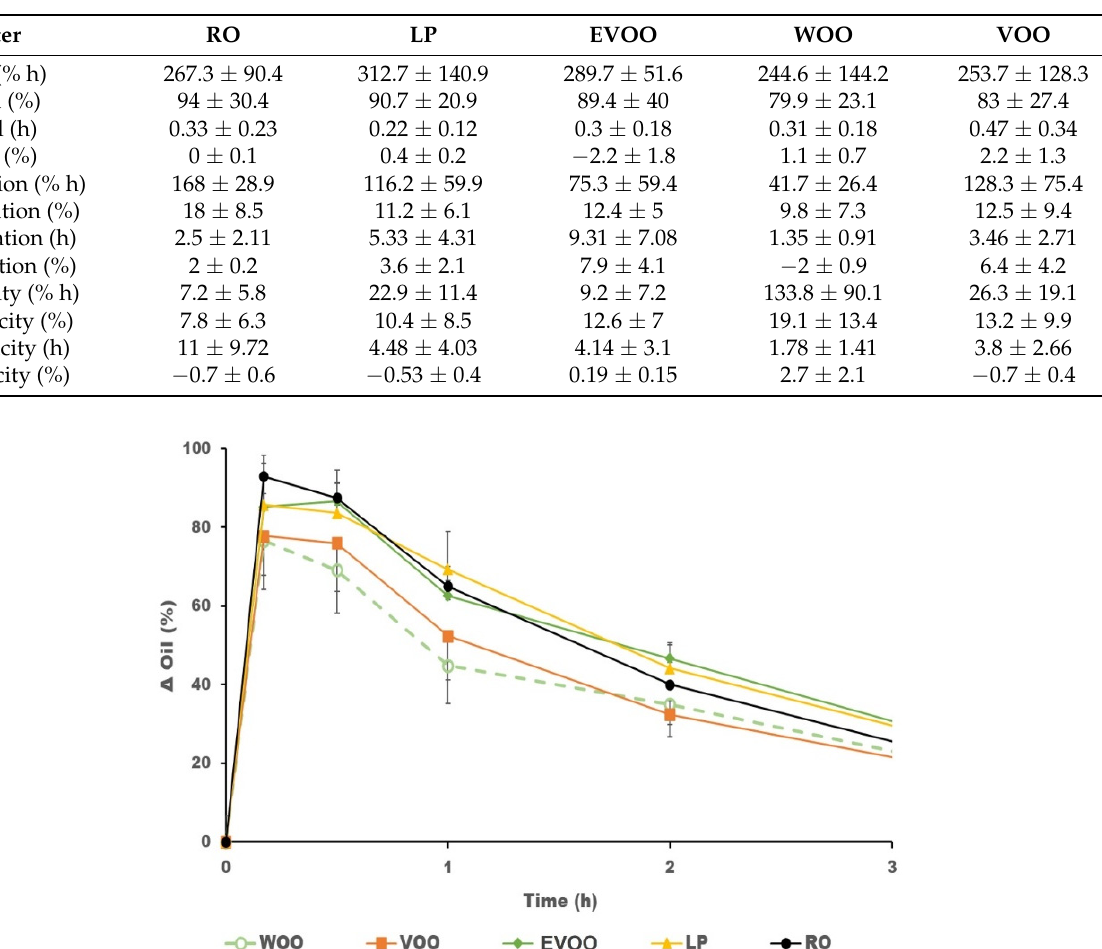
Table 3. In vivo performance of the various oils tested in eight healthy volunteers. Mean results ± standard deviation.